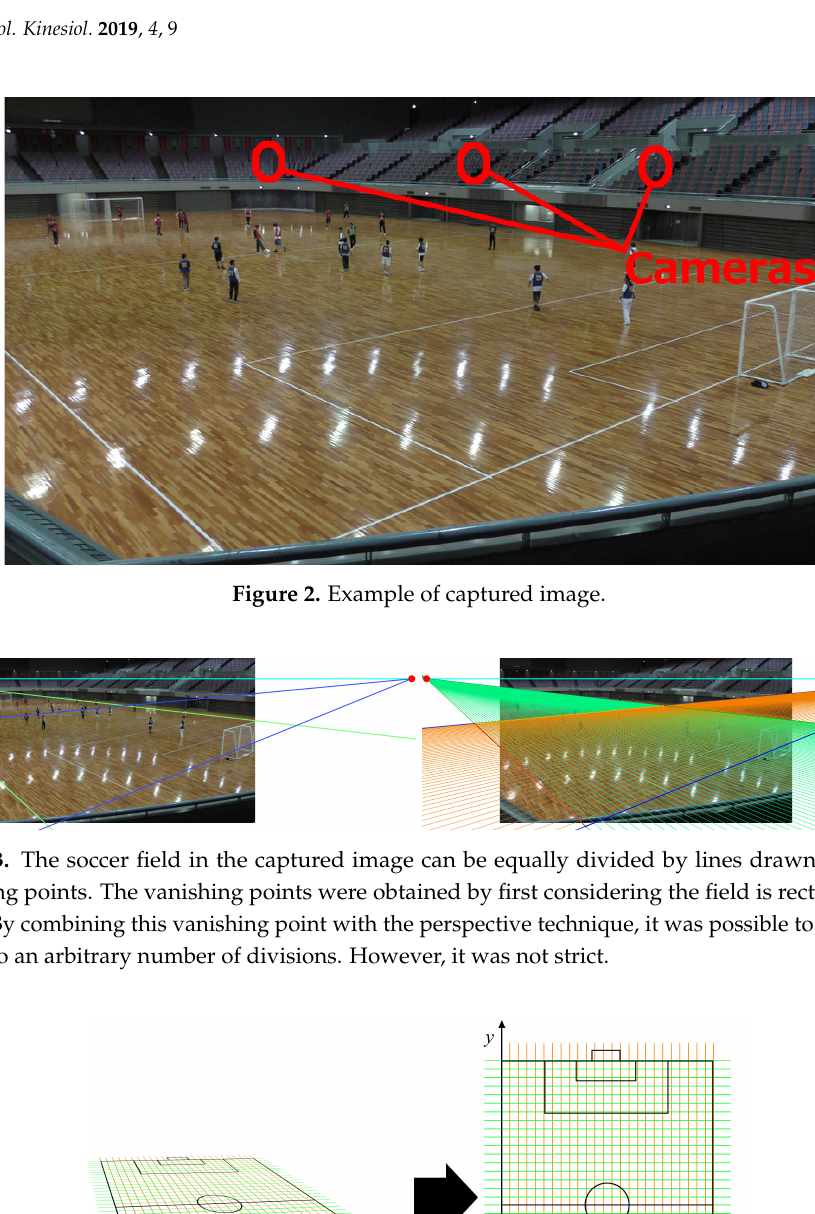
Unity-chan, a virtual character having the 3D model shown in Figure 5, was adopted to represent players on the soccer field. By using the virtual space, represented by the 3DCG technology, we could easily obtain images captured from arbitrary